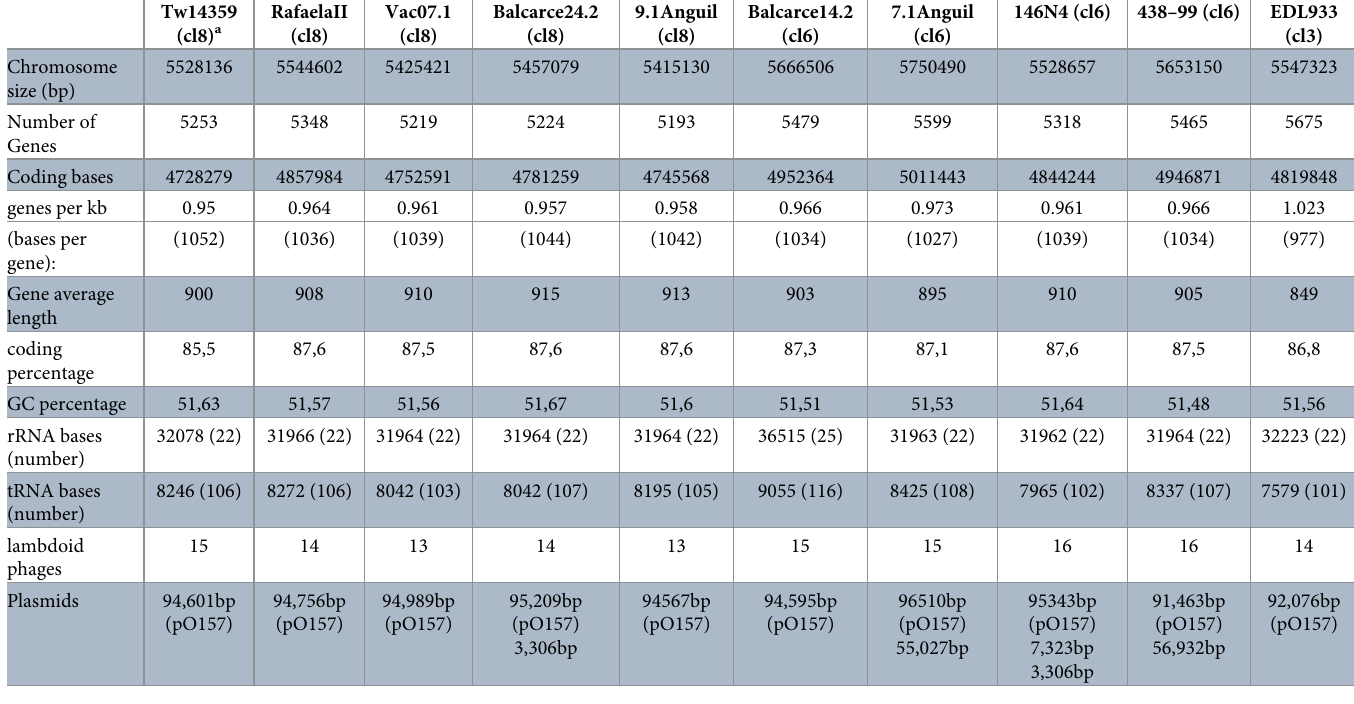
Table 2. Chromosome and plasmid characteristics from the sequenced strains and two previously published